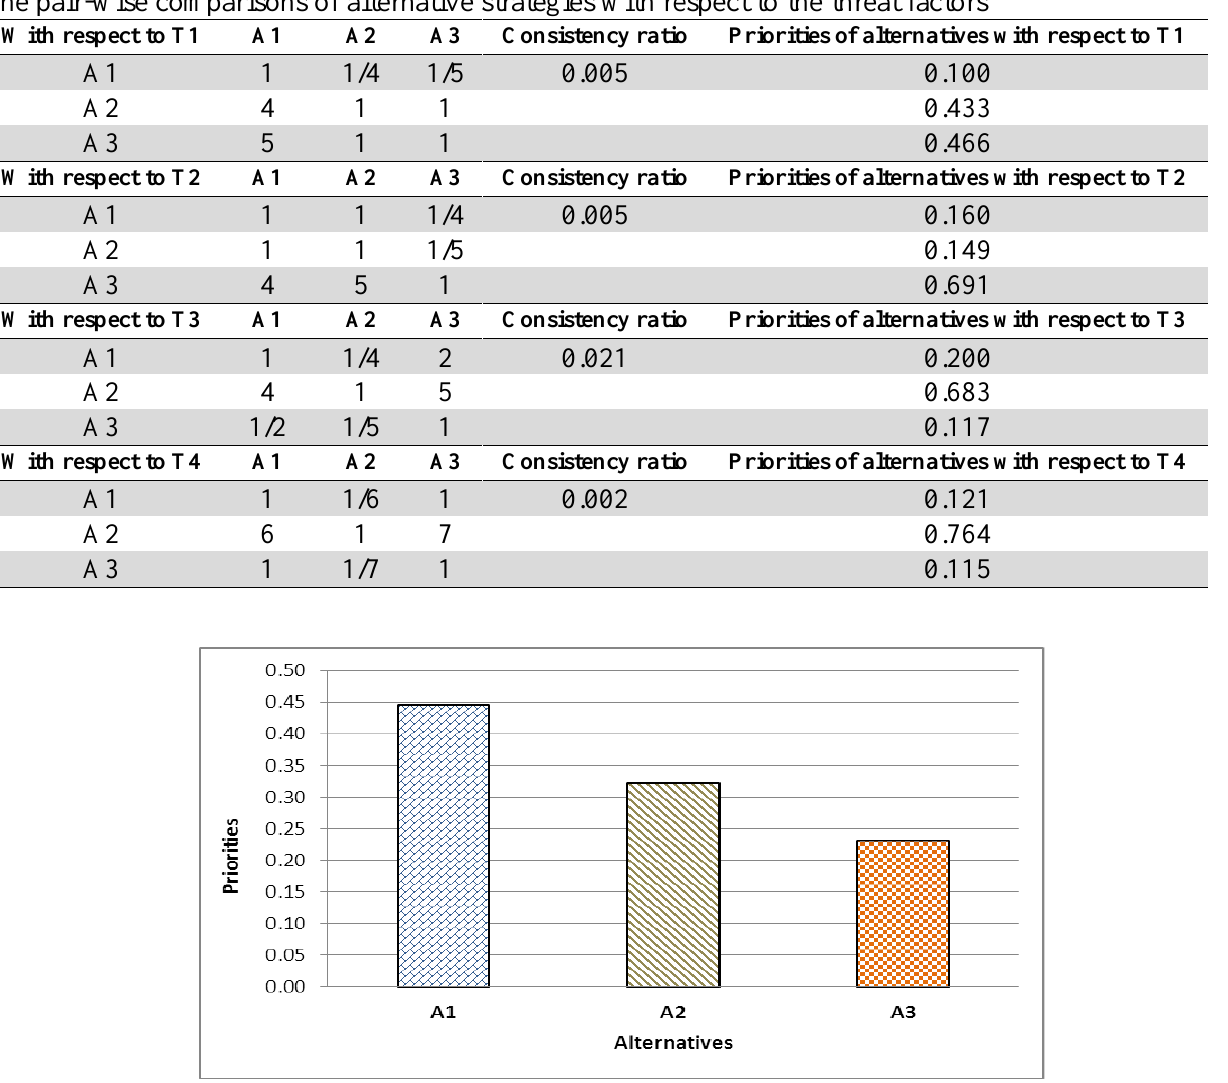
Fig. 3. Priorities of strategic management